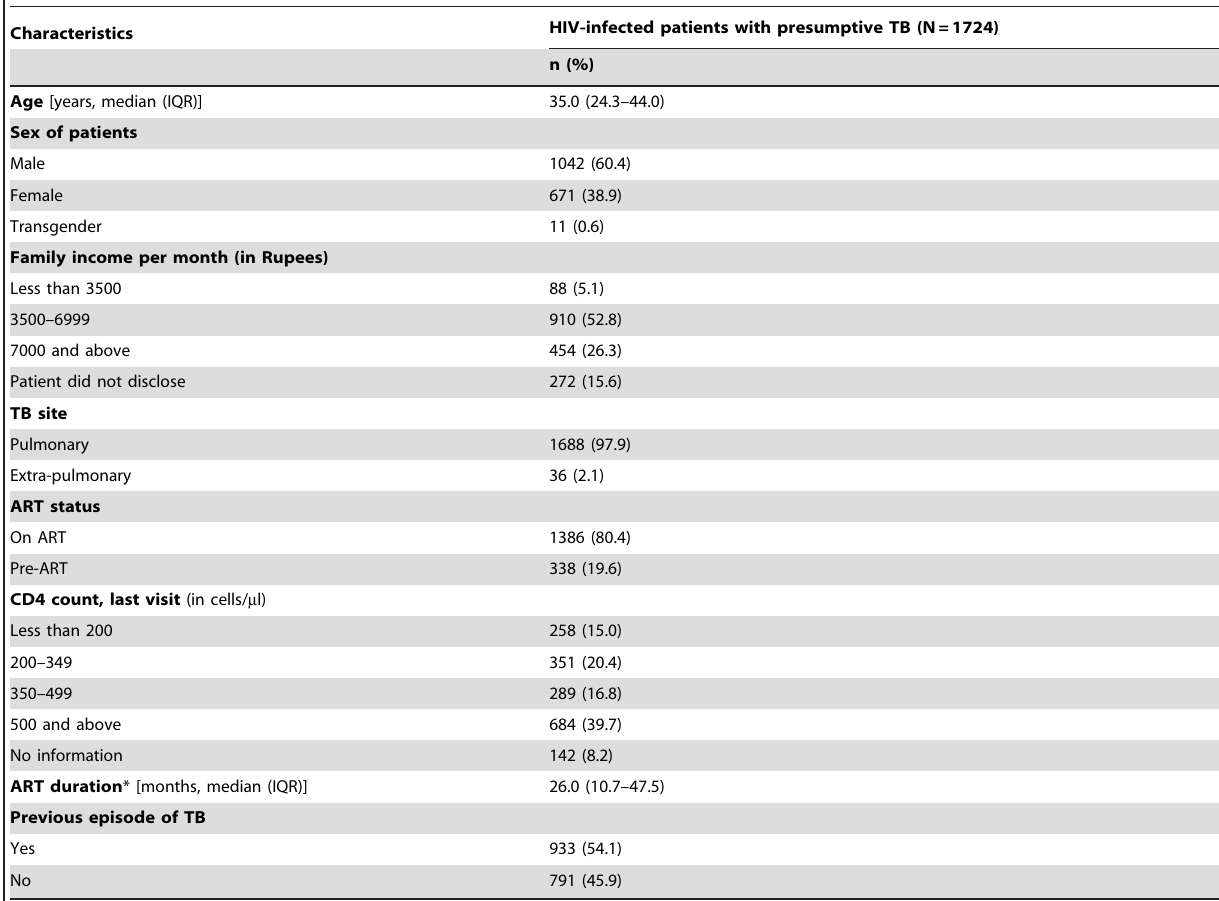
Table 1. Demographic and clinical characteristics of HIV-infected patients with presumptive TB, Mumbai, India.